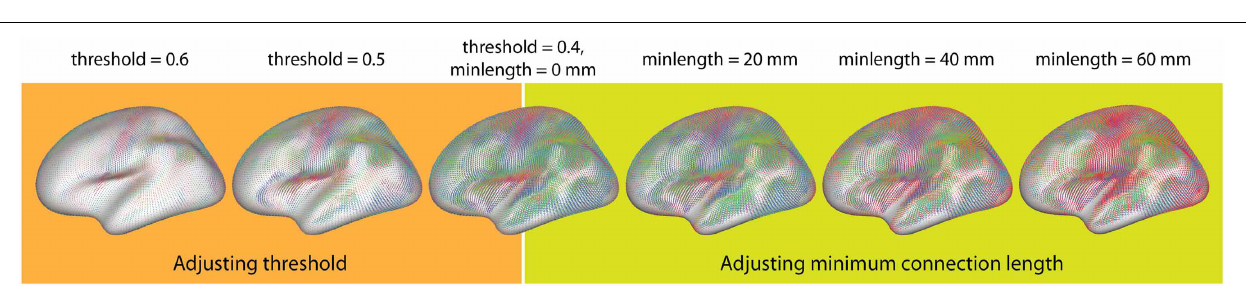
FIGURE 11 | Interactive exploration of the two free parameters of glyph visualization. This example demonstrates the effects of adjusting the thresholding ( Left ) and removing short connections ( Right ).